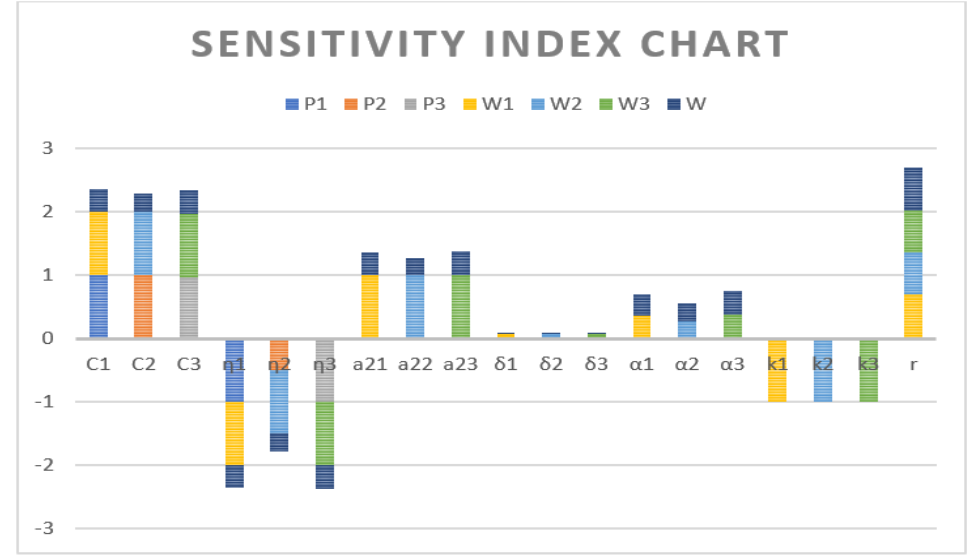
Figure 6. Sensitivity Index Chart.